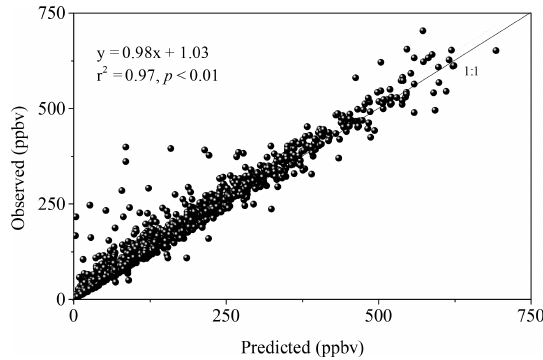
Figure A3. Scatter plots between the total predicted and observed VOC concentrations based on the five-factor PMF